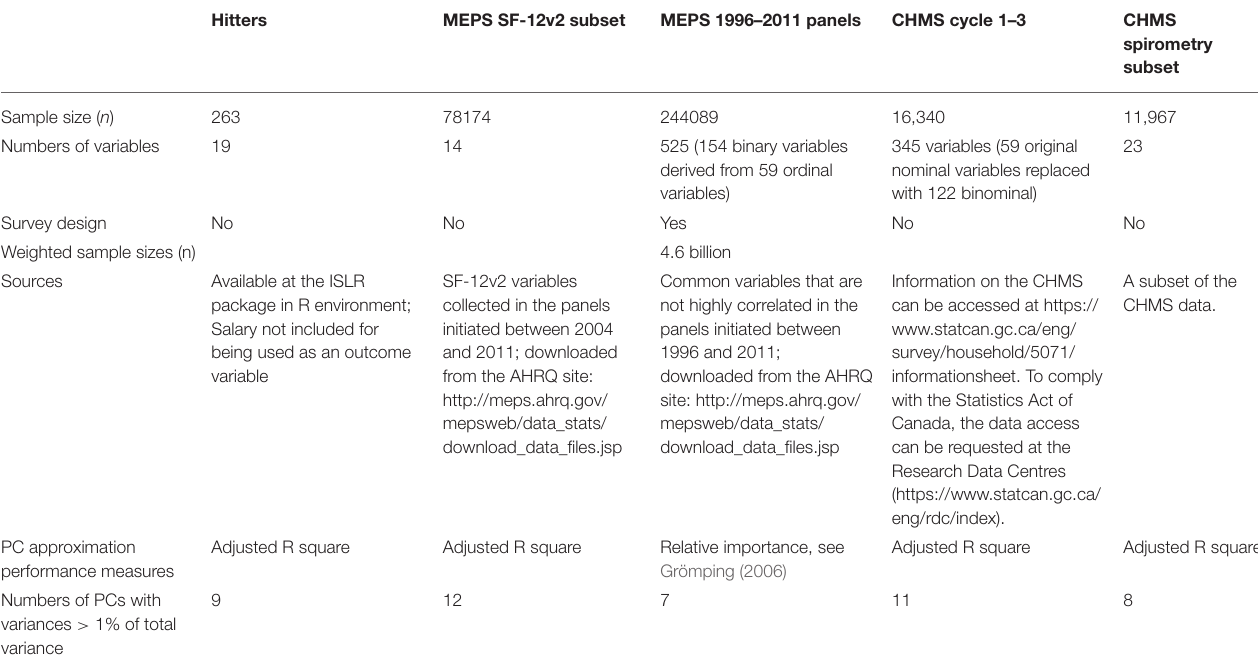
TABLE 1 | Characteristics of data sets used for PC